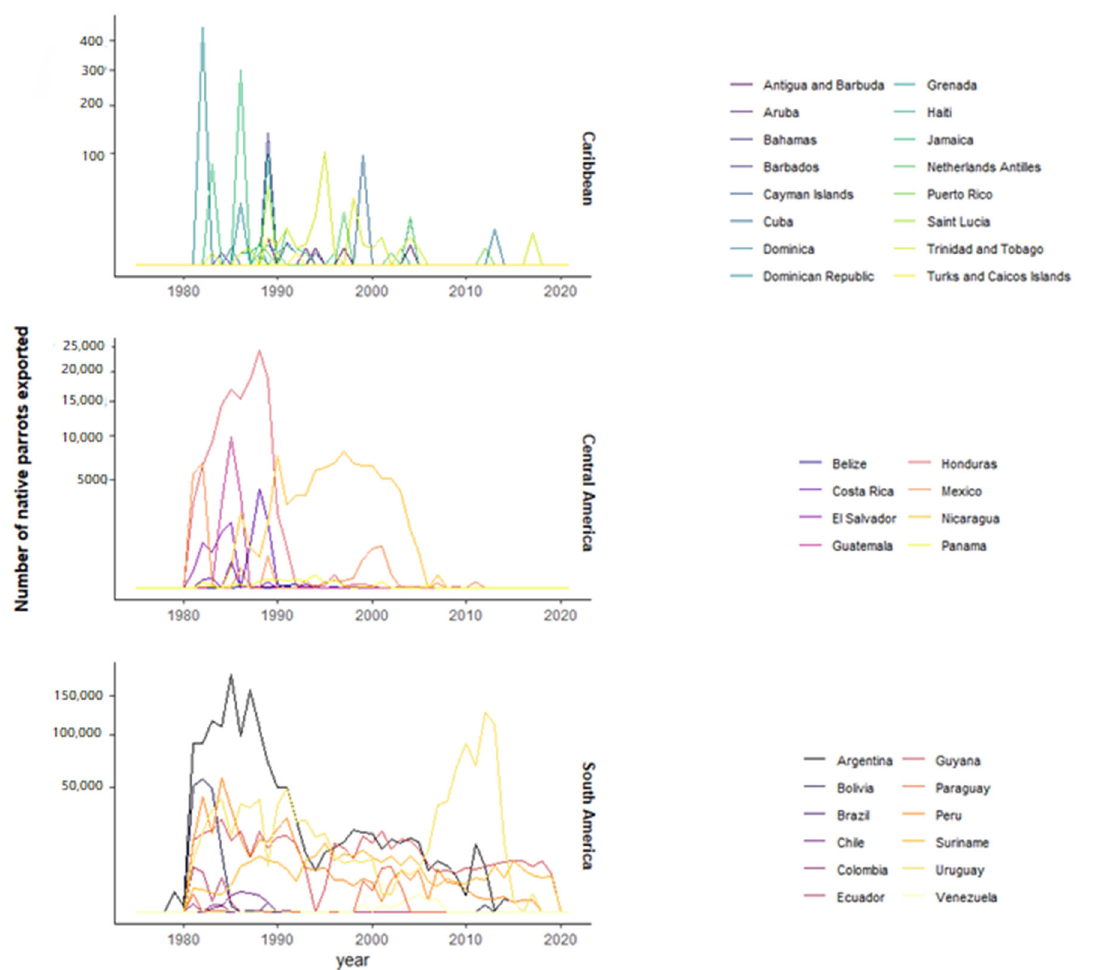
Figure 3. Number of wild ‐ sourced parrots annually exported from each Neotropical country, grouped by subregions. Note different scales for each subregion.